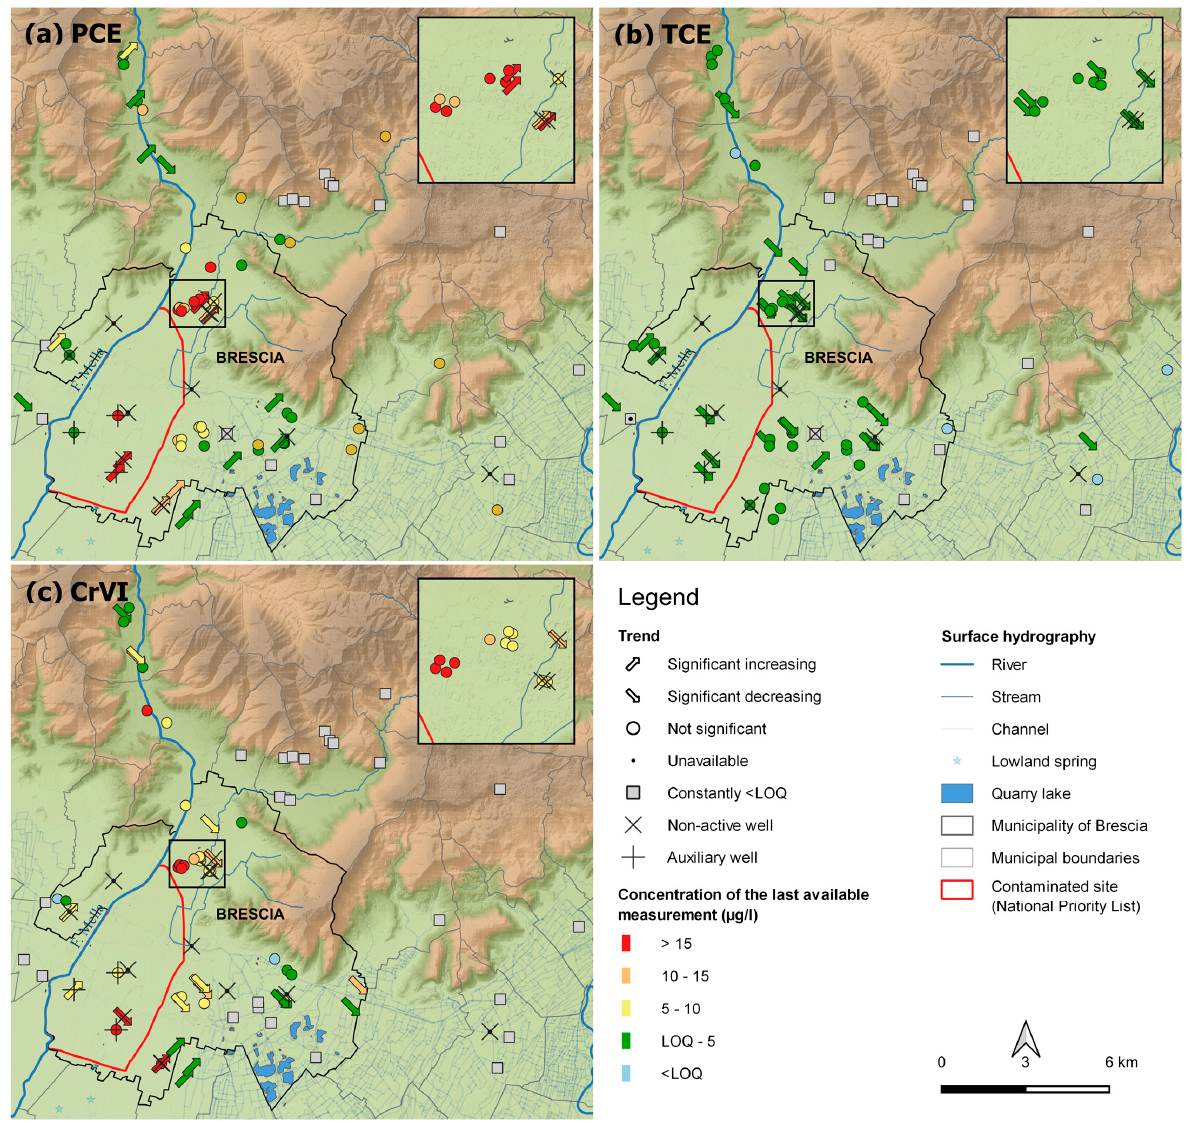
Figure 3. Exploratory trend analysis for ( a ) PCE, ( b ) TCE and ( c )